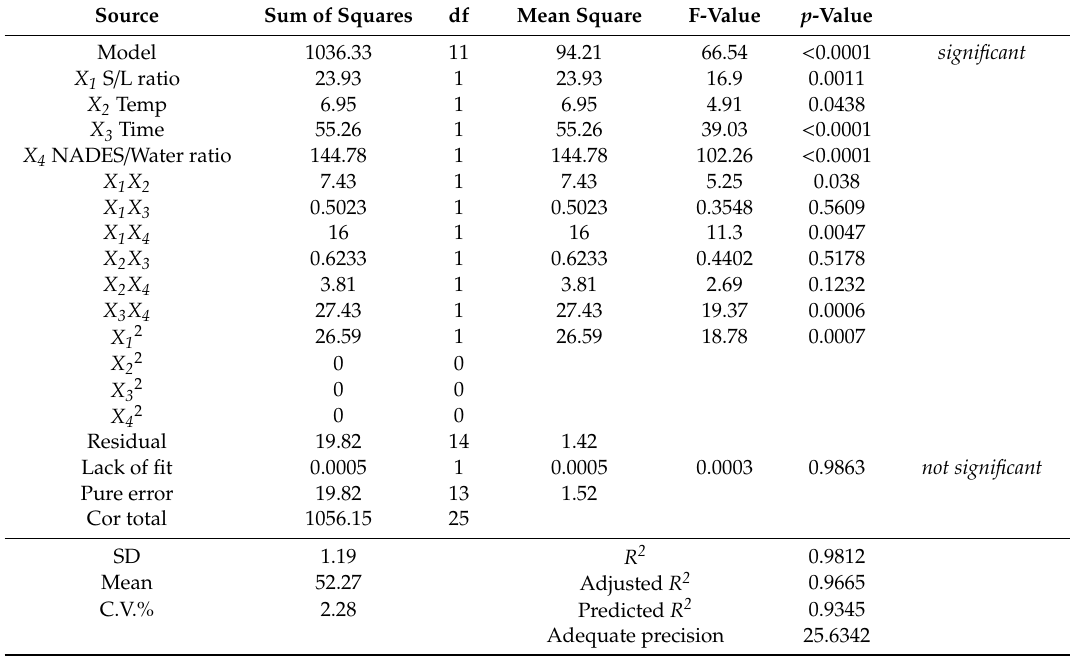
Table 7. Analysis of variance (ANOVA) for DSD for DE% using ChCl–Glc–W and its fit statistics.